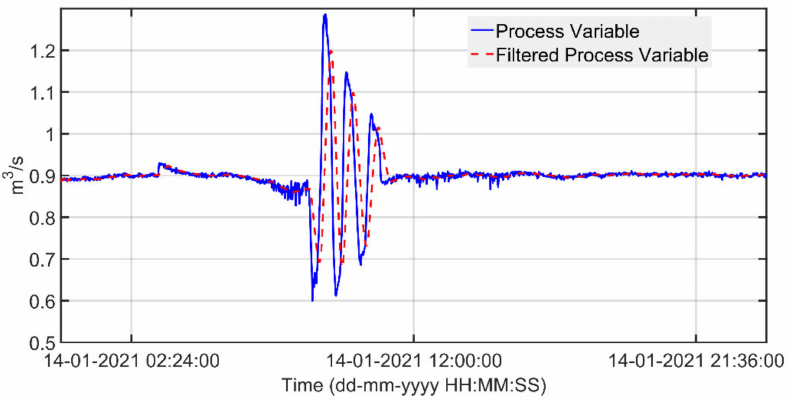
Figure 9. Data analysis results: upstream reservoir intake process variable and filtered process variable.